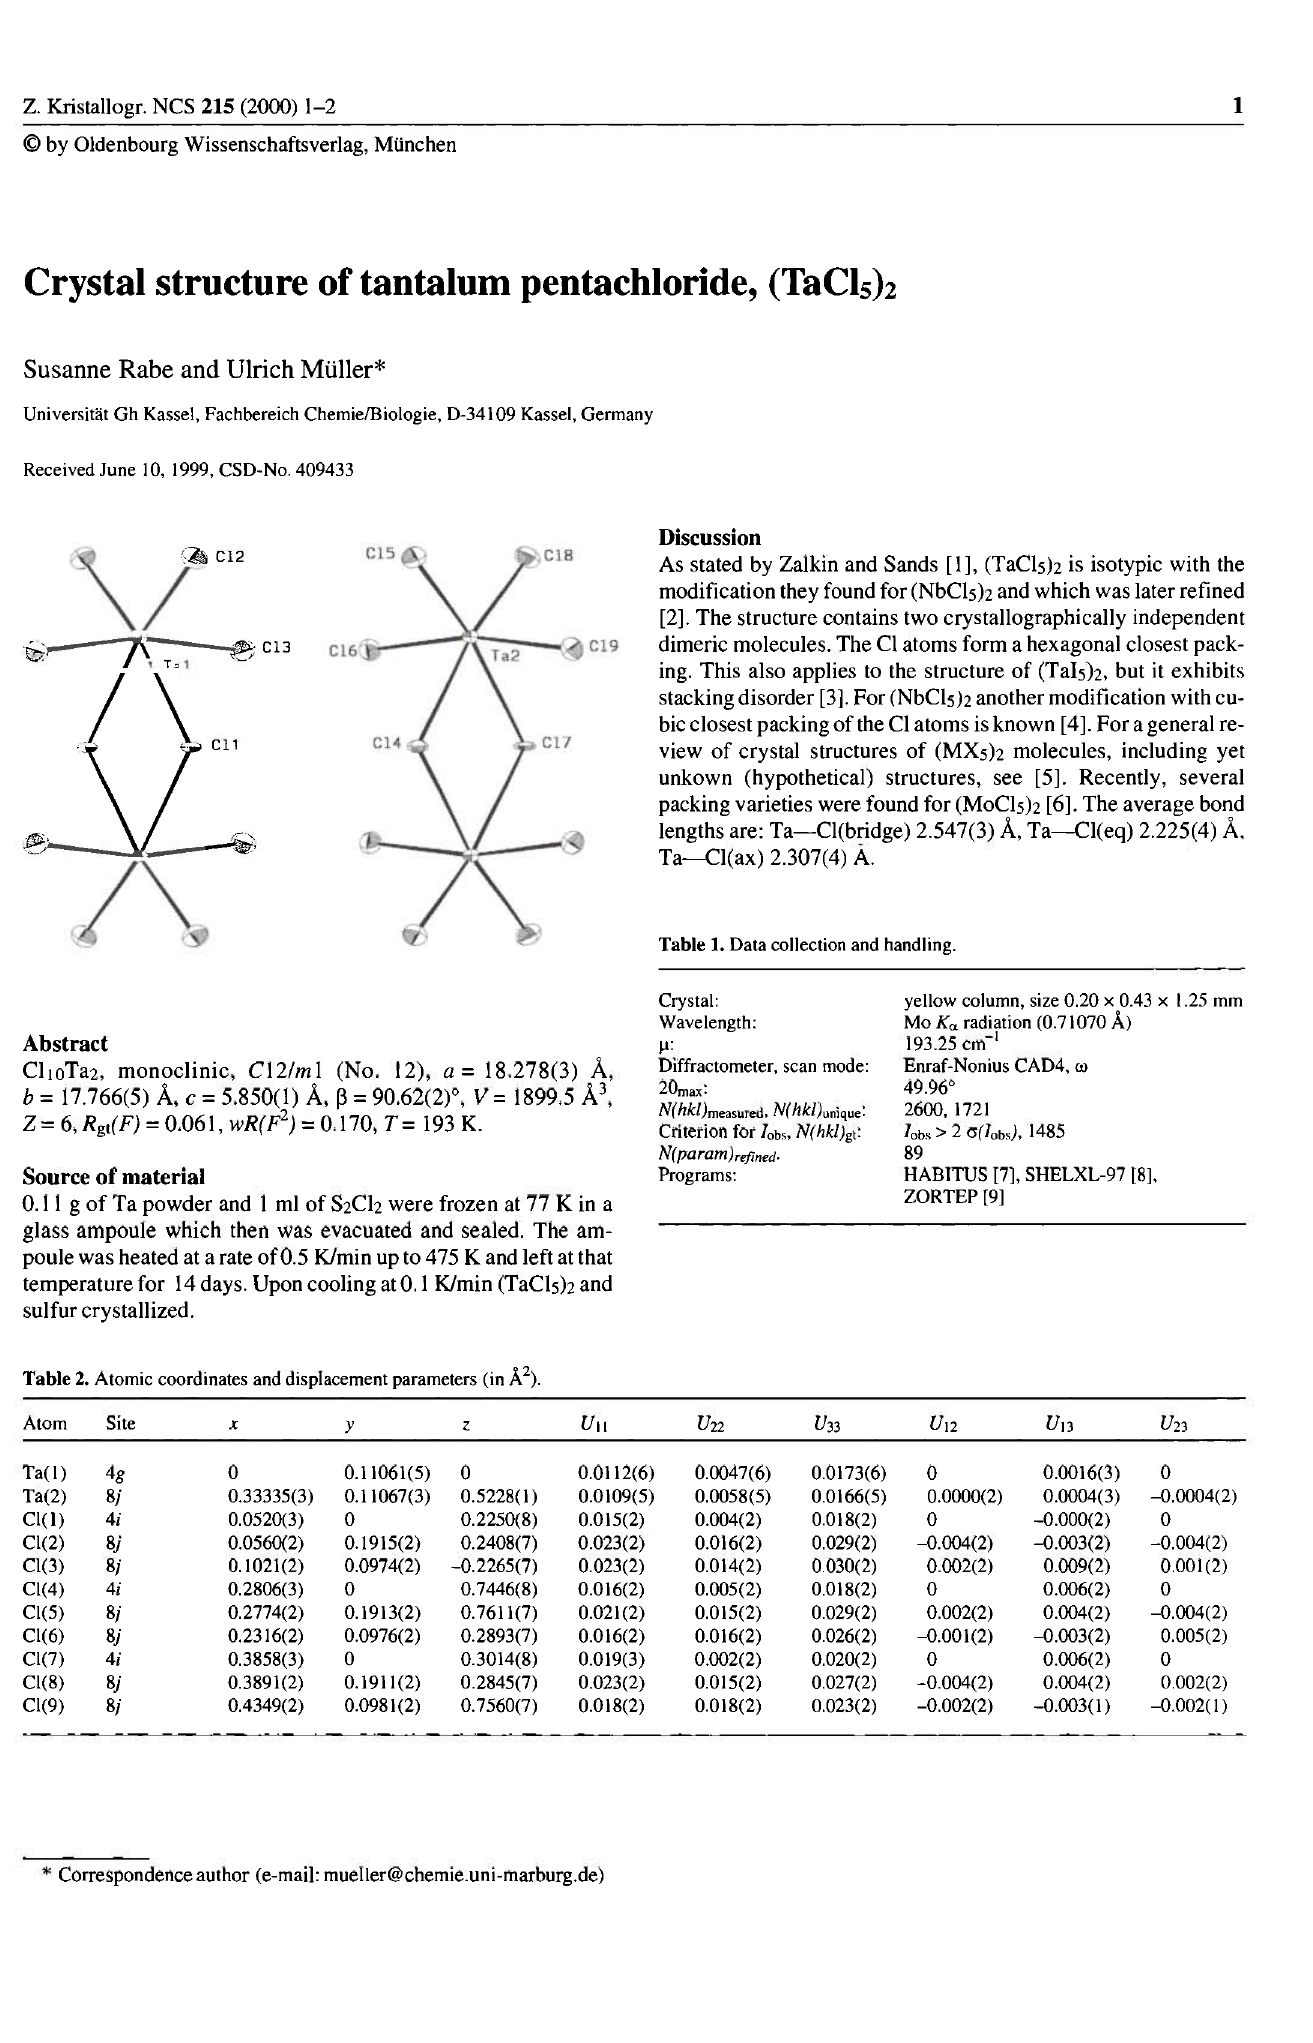
Table 2. Atomic coordinates and displacement parameters (in Ä 2